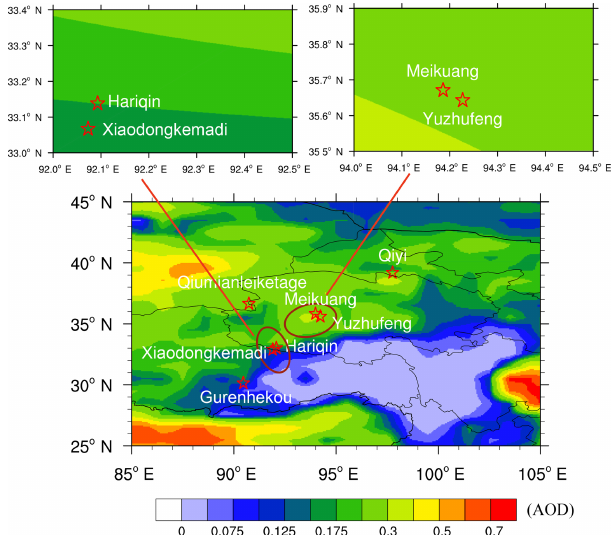
Figure 4. Spatial distribution of the median absorption Ångström exponent for (a) total particulate constituents ( Å tot ) and (b) non-BC particulate constituents ( Å non-BC ) for each